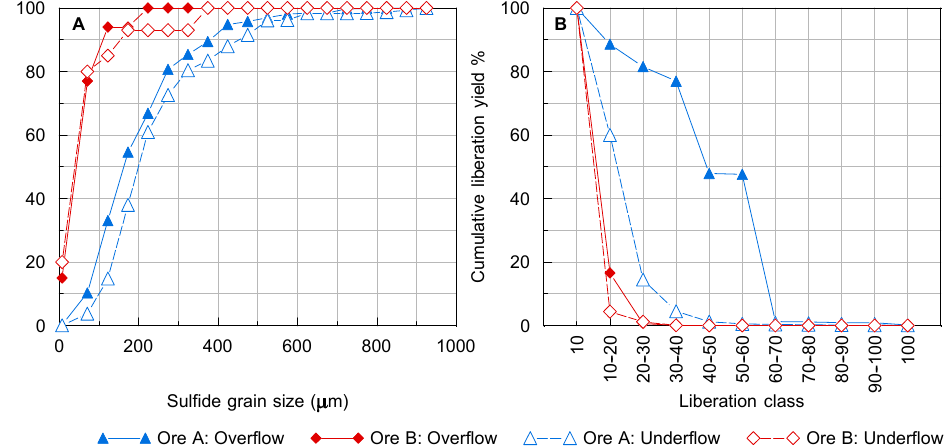
Figure 8. Cumulative sulfide grain size distribution ( A ) and cumulative liberation yield ( B ) in the cut-point samples of ore A (3.1 floats) and ore B (3.0 floats) DMC products.